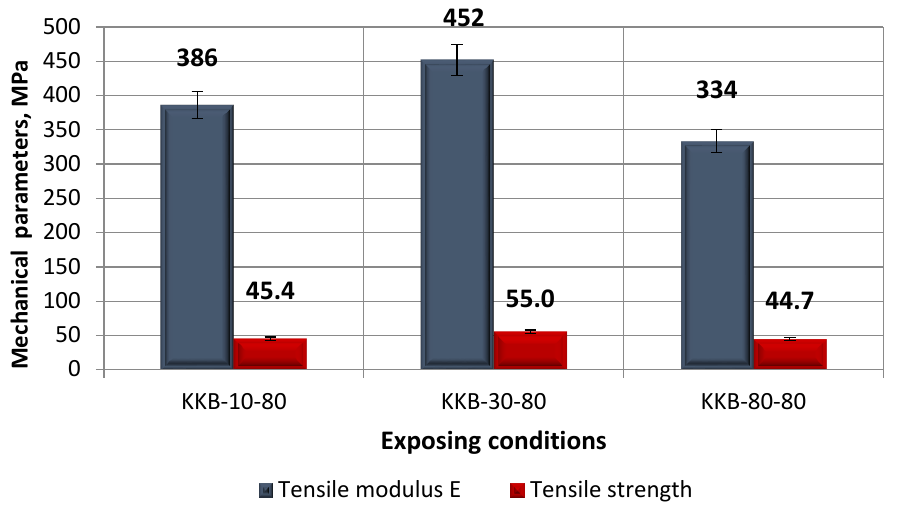
Figure 16. Tensile modulus and tensile strength of samples exposed to selected ageing variants.